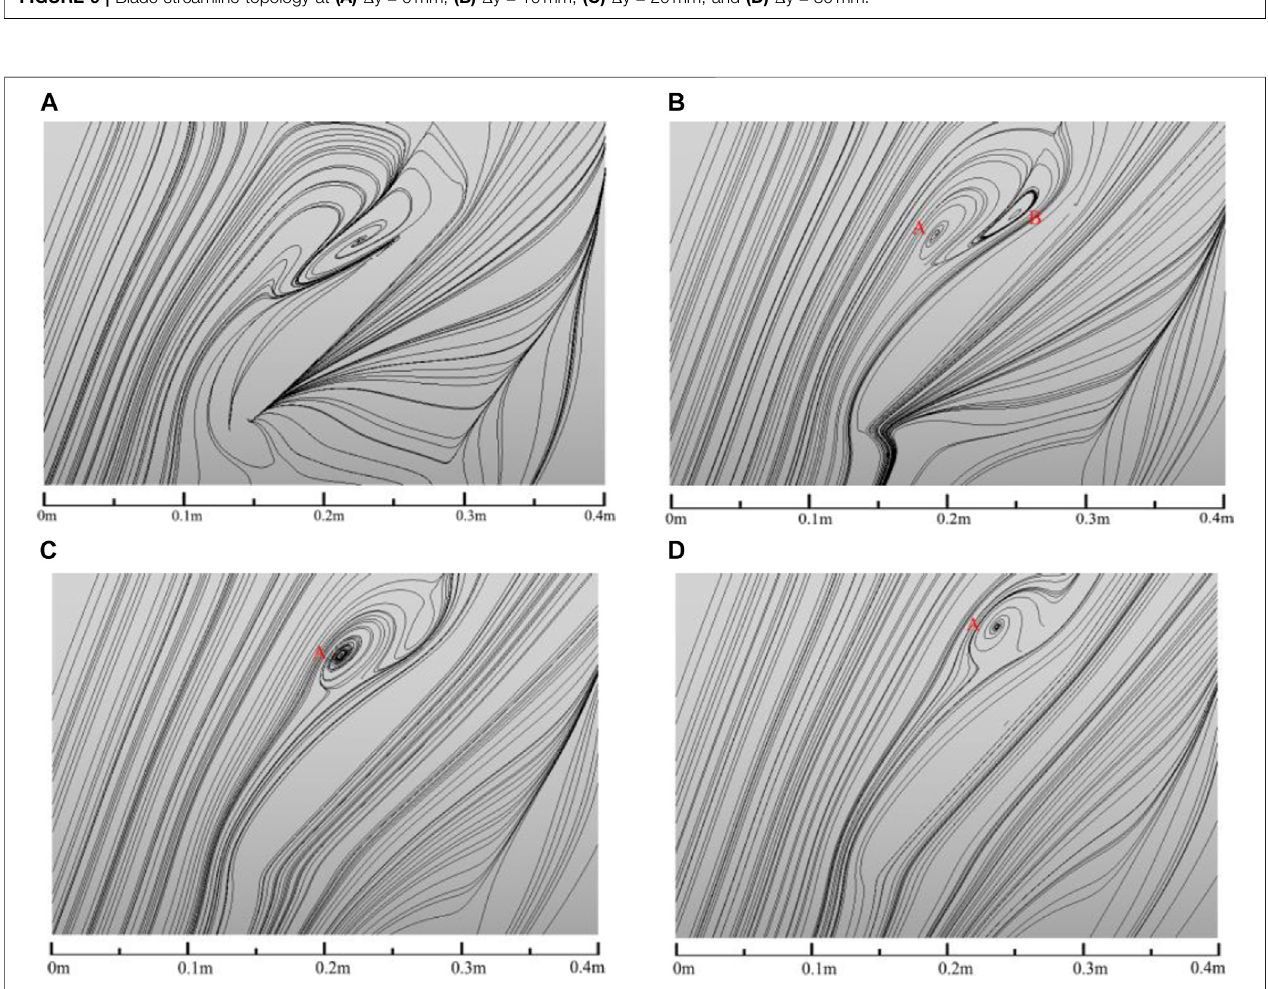
FIGURE 10 | Streamline topology at (A) 0% Span, (B) 1% Span, (C) 2% Span, and (D) 5% Span.